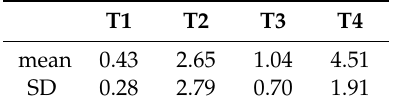
Table 7. Mean and SD of Macrophages (CD68).